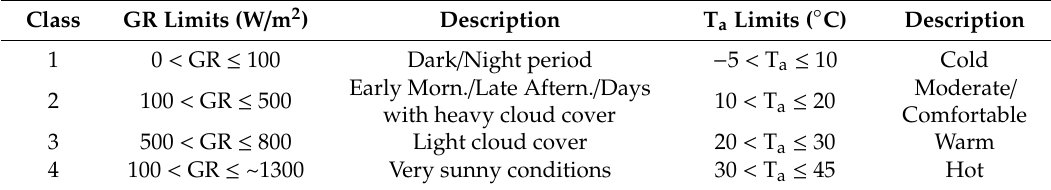
Figure 4. The flowchart of the thermal comfort and sensitivity analysis methodology. Table 4. Stipulated valuable thresholds for the classes of Global Radiation (GR) and Air Temperature (T a